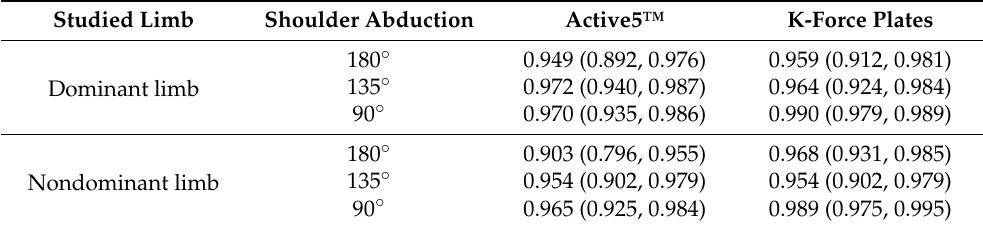
Table 10. Inter-rater reliability of the ASH test using both studied devices in the male group. Studied Limb Shoulder Abduction Active5™ K-Force Plates 180 ◦ 0.949 (0.892, 0.976) 0.959 (0.912, 0.981) 135 ◦ 0.972 (0.940, 0.987) 0.964 (0.924, 0.984) Dominant limb 90 ◦ 0.970 (0.935, 0.986) 0.990 (0.979, 0.989) 180 ◦ 0.903 (0.796, 0.955) 0.968 (0.931, 0.985) 135 ◦ 0.954 (0.902, 0.979) 0.954 (0.902, 0.979) Nondominant limb 90 ◦ 0.965 (0.925, 0.984) 0.989 (0.975, 0.995)